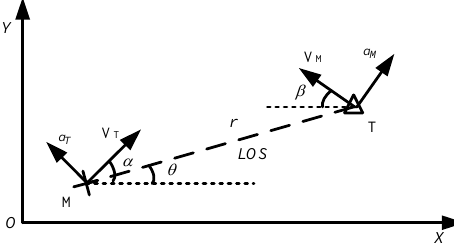
Figure 1. Missile–target engagement Figure 1. Missile – target engagement geometry.